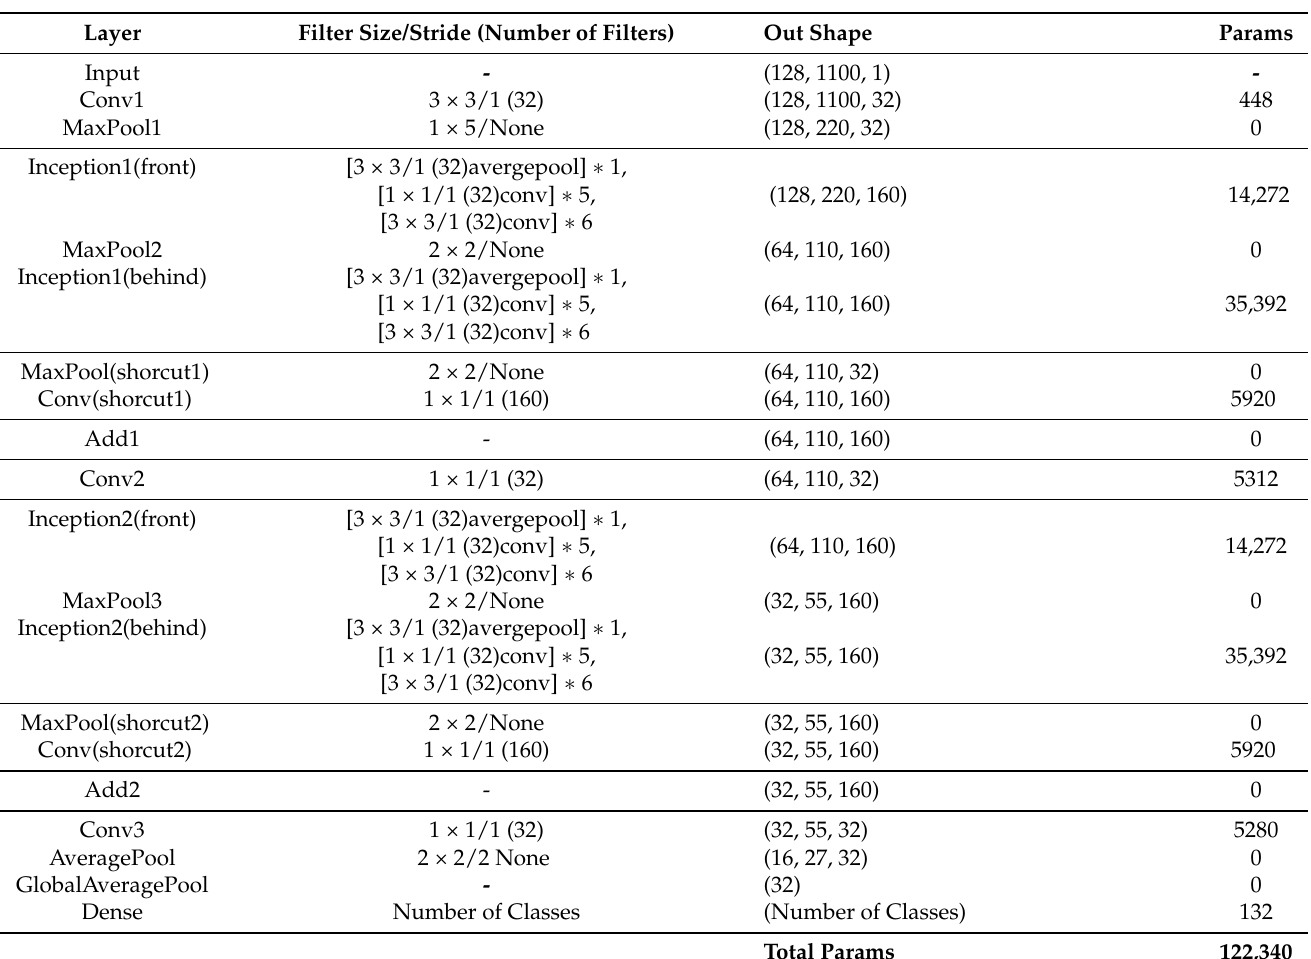
Table 2. The configuration of proposed model. The dimension of output shape represent in frame length, Mel features, and